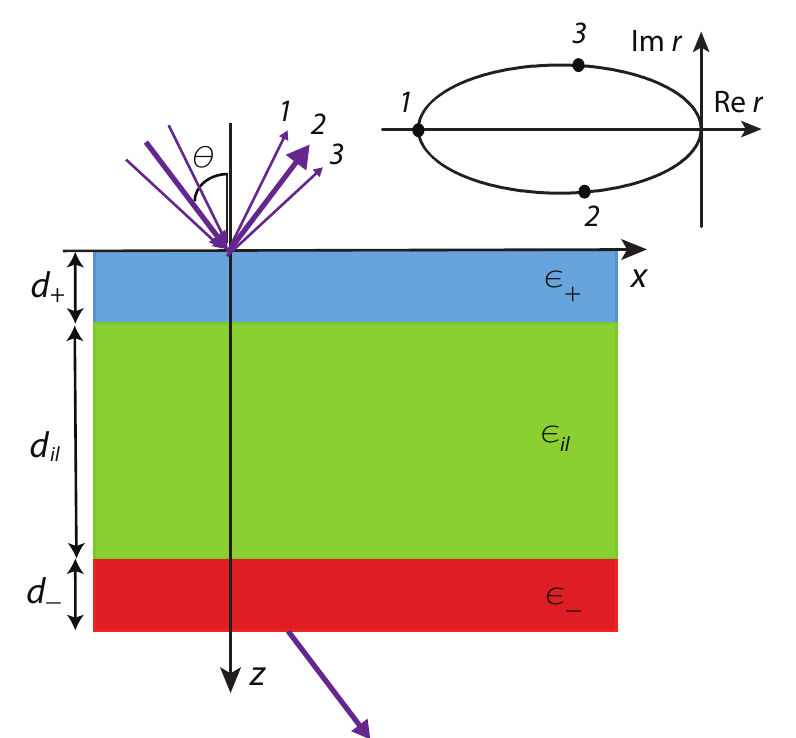
Figure 1. Schematic of a PT -symmetric trilayer consisting of the outer layers with loss and gain ENZ media, respectively, and the dielectric spacer (or interlayer). The outer layers have the non- Hermiticity parameter γ and the thicknesses d ± = λ p /2 π (i.e., ω p d ± / c = 1, where c is the speed of light). The spacer has the thickness d il = 10 d ± and permittivity ε il = 5.